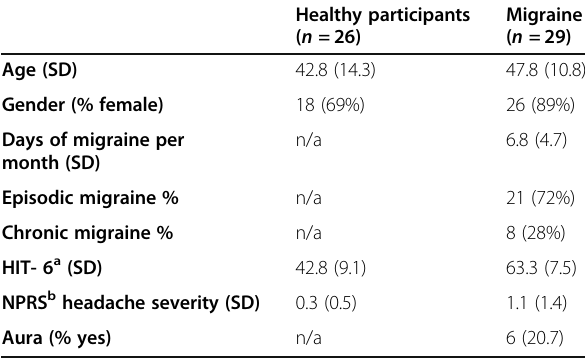
Table 1 Main characteristics at baseline of healthy participants and people with